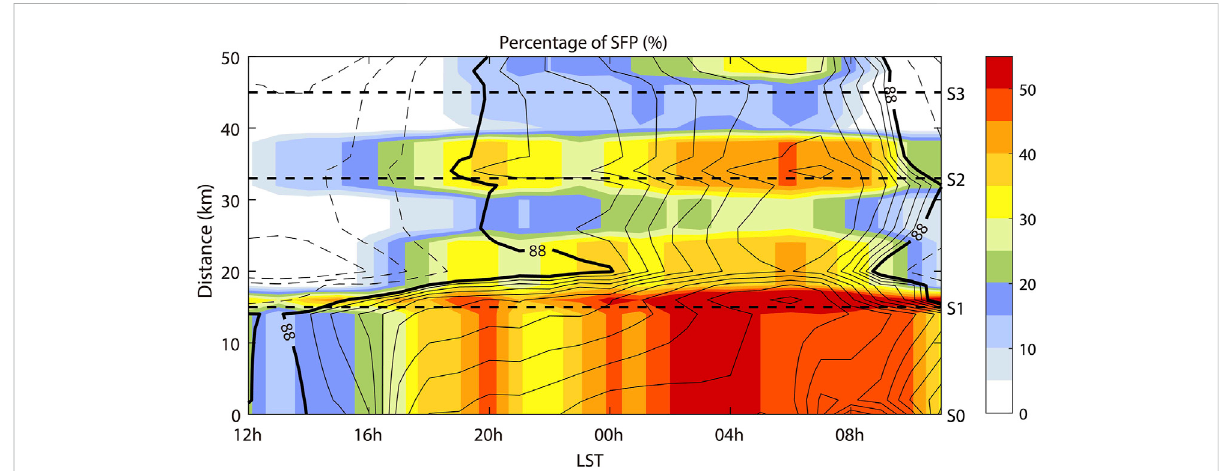
FIGURE 5 Compositeresults ofdevelopmentinSFP(%;shading) andRH(%;contouring) forall SFPeventsalongthearrowinFigure4A.The percentage of SFPisthemeanvalueoffogconditions(fogis100andnofogis0)amongallSFPevents.TheintervalofRHis1%amongsolidlinesanditis5%among dashedlines.The Y axisisthedistancefromtheS0stationalongthearrowinFigure4A.ThedistancefromS0toS1,S2,andS3areindicatedbydashed lines. The results along the arrow are interpolated by AWSs. LST is local standard